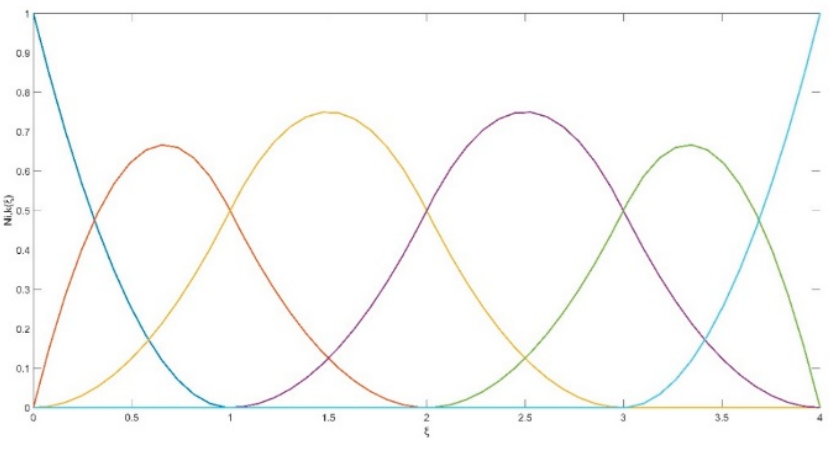
Figure 1. Basis function for k = 3 and Ξ = [ 0 0 0 1 2 3 4 4 4 ]